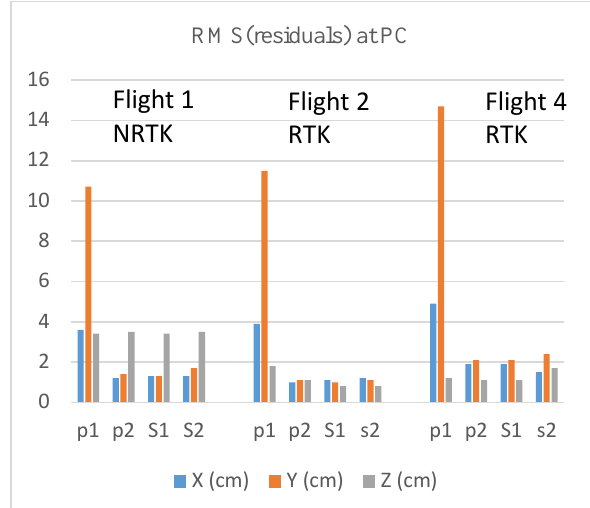
Figure 3. RMS of the residuals on the PC coordinates, according to the BBA calibration settings, for Flight 1, 2 and 4.